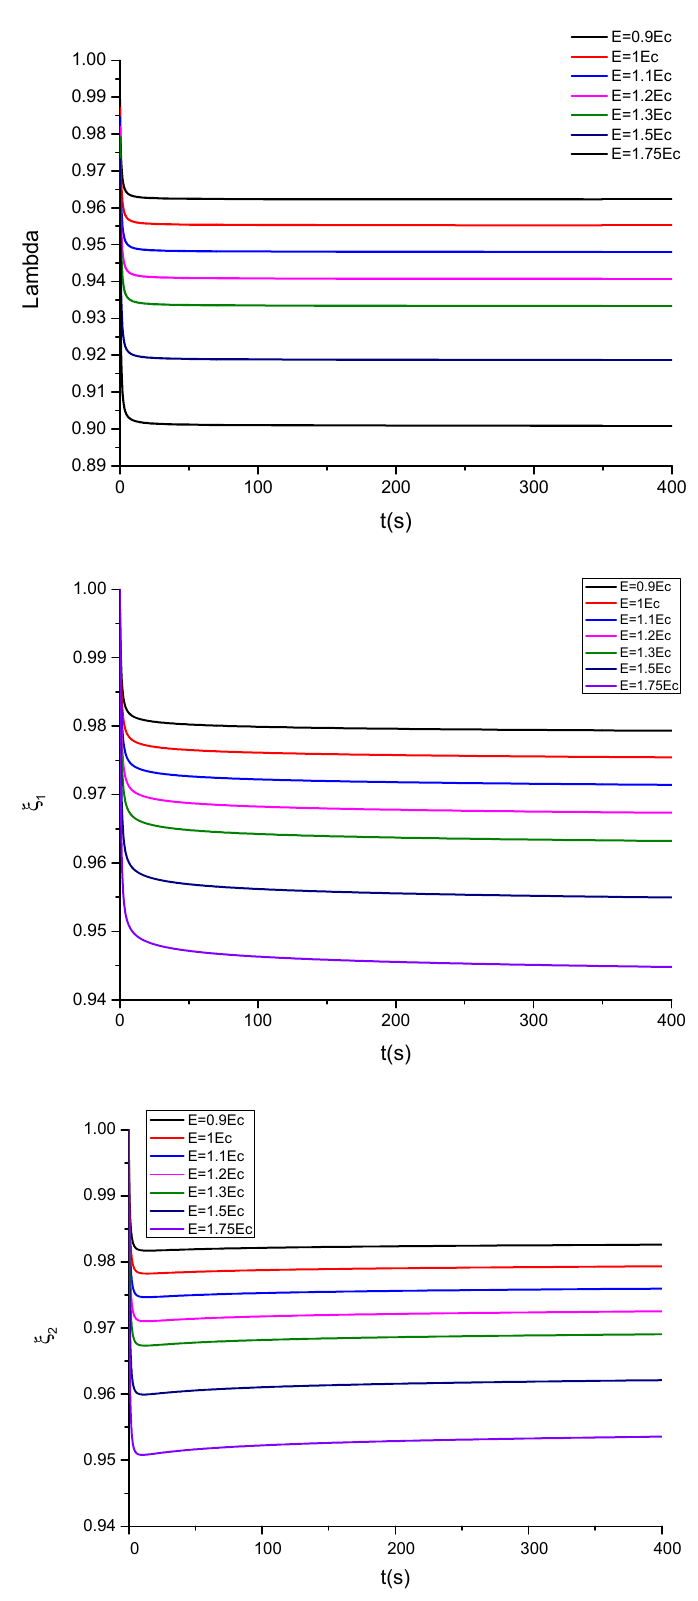
Figure 7. Plots showing the evolution of λ , ξ 1 and ξ 2 as a function of time for different values of the electric field E, for the case of floating electrodes without mechanical stresses.